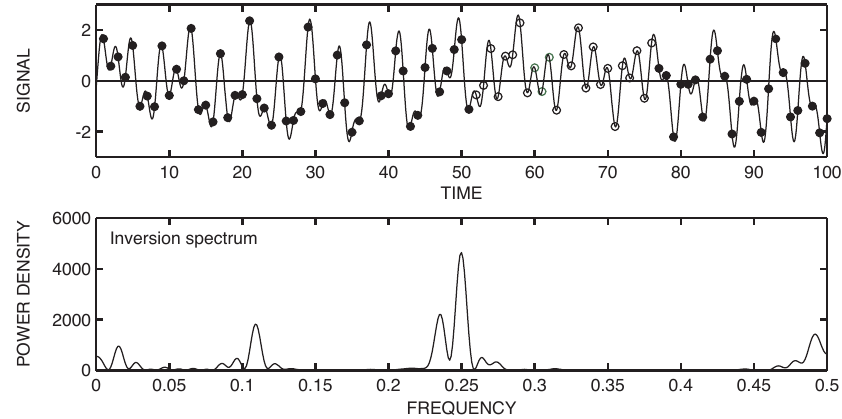
Fig. 5. Same as Fig. 2, but the inversion spectrum is calculated from a sample sequence with a gap of 25 samples in the sample